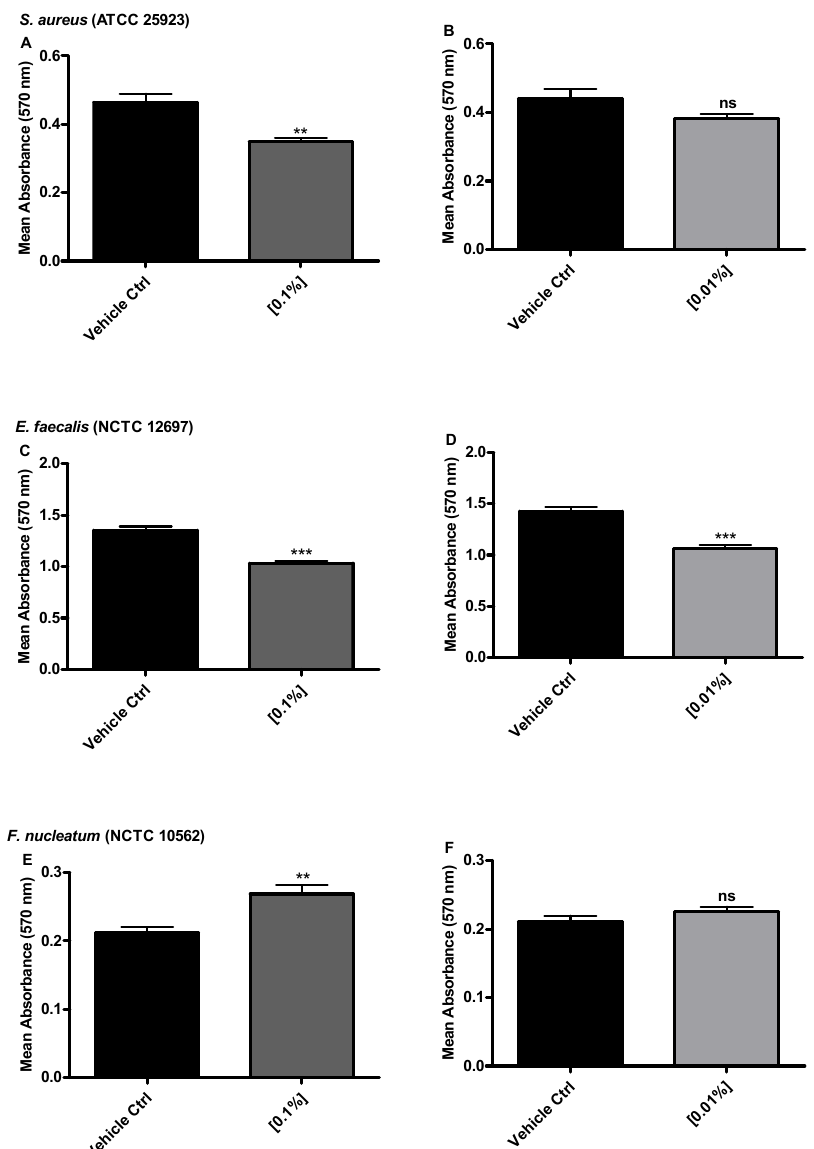
Figure 4. Biofilm inhibition determined by biofilm biomass using the crystal violet assay. ( A , B ) S. aureus, ( C , D ) E. faecalis and ( E , F ) F. nucleatum biofilm biomass after 24 h incubation with 0.1% and 0.01% w / v peptide concentration of NapFF ε K ε K-OH. Results are displayed as the average ( ± standard error) of three independent experiments (three replicates per experiment). All comparisons were made with the appropriate vehicle control. Mann–Whitney non parametric testing was employed for statistical analysis. ns: no significant difference ( p > 0.05), **: p ≤ 0.01, ***: p ≤ 0.001. The antibacterial activity of the assembled 0.5% w / v NapFF ε K ε K ‐ OH hydrogel